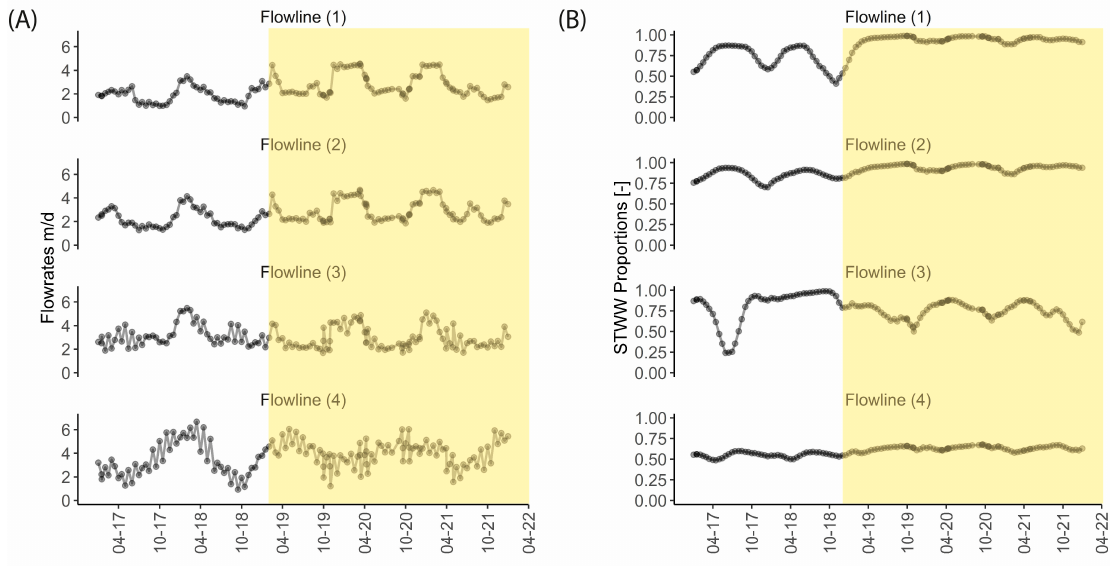
Figure 12. Variations in ( A ) average flow velocities and ( B ) STWW proportions, calculated by the model according to the flow lines from the infiltration ponds 1, 2, and 3 (Flowlines 1, 2, and 3) and between the Goulot and the sea (Flowline 4). The orange area represents the period when the alternation of STWW discharges into the different infiltration ponds was interrupted.